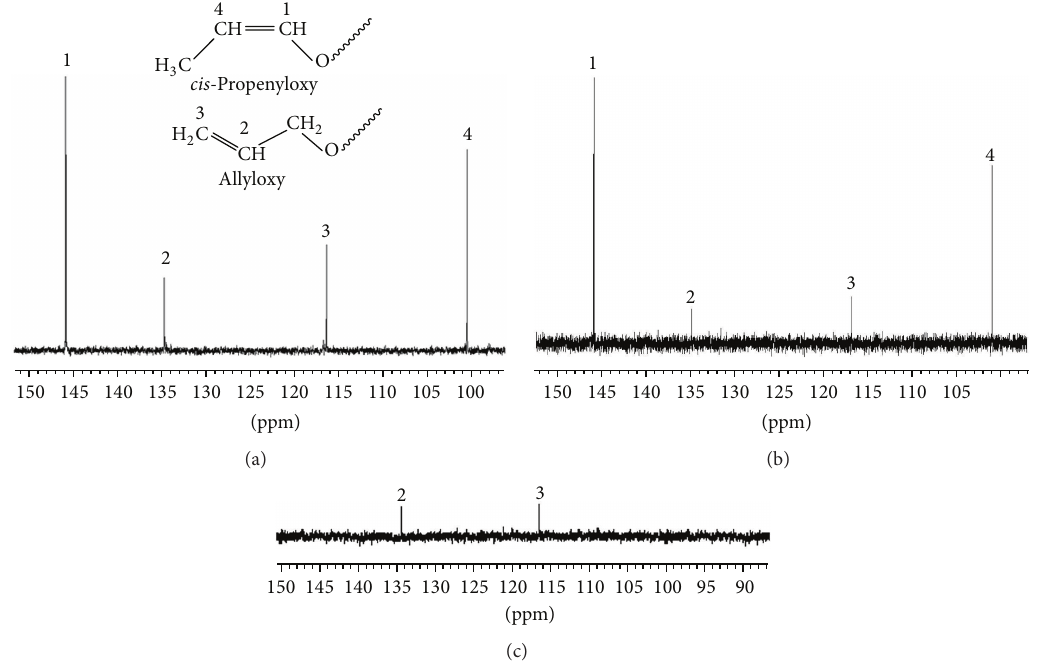
Figure 1: Unsaturated region in 13 C NMR spectra of polymers: (a) sample 1; (b) sample 2; and (c) sample